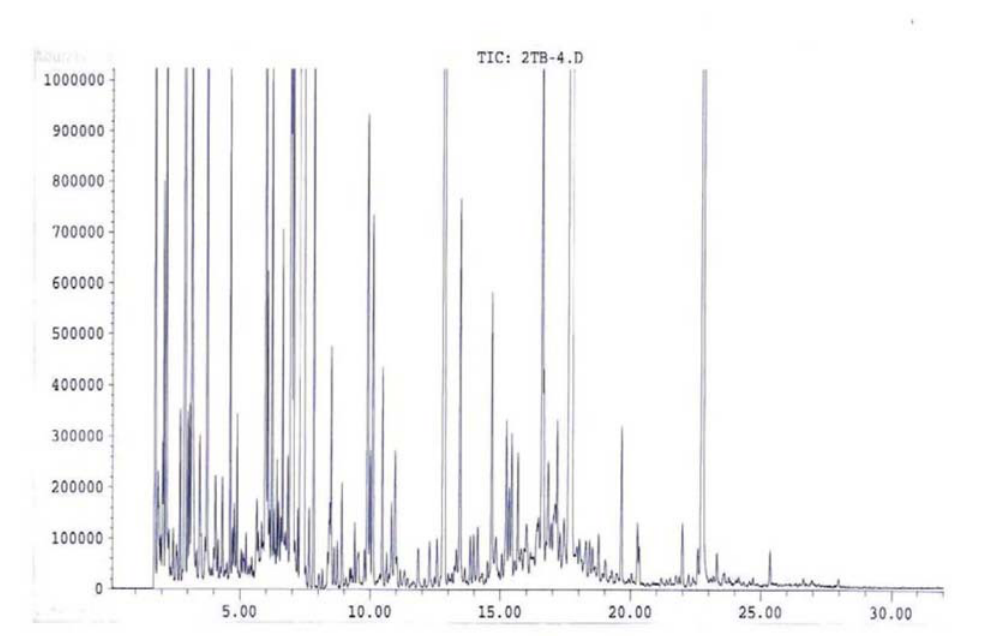
FIGURE 2 . Total ion chromatogram of an air sample collected in a Tedlar bag, preconcentration volume 300 ml.